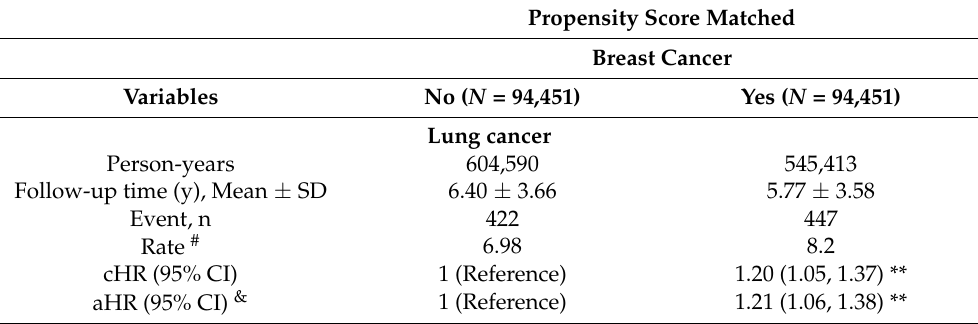
Table 4. Overall lung cancer incidence (per 1000 person-years) and estimated HRs in breast cancer patients compared with those without breast cancer in the propensity-score